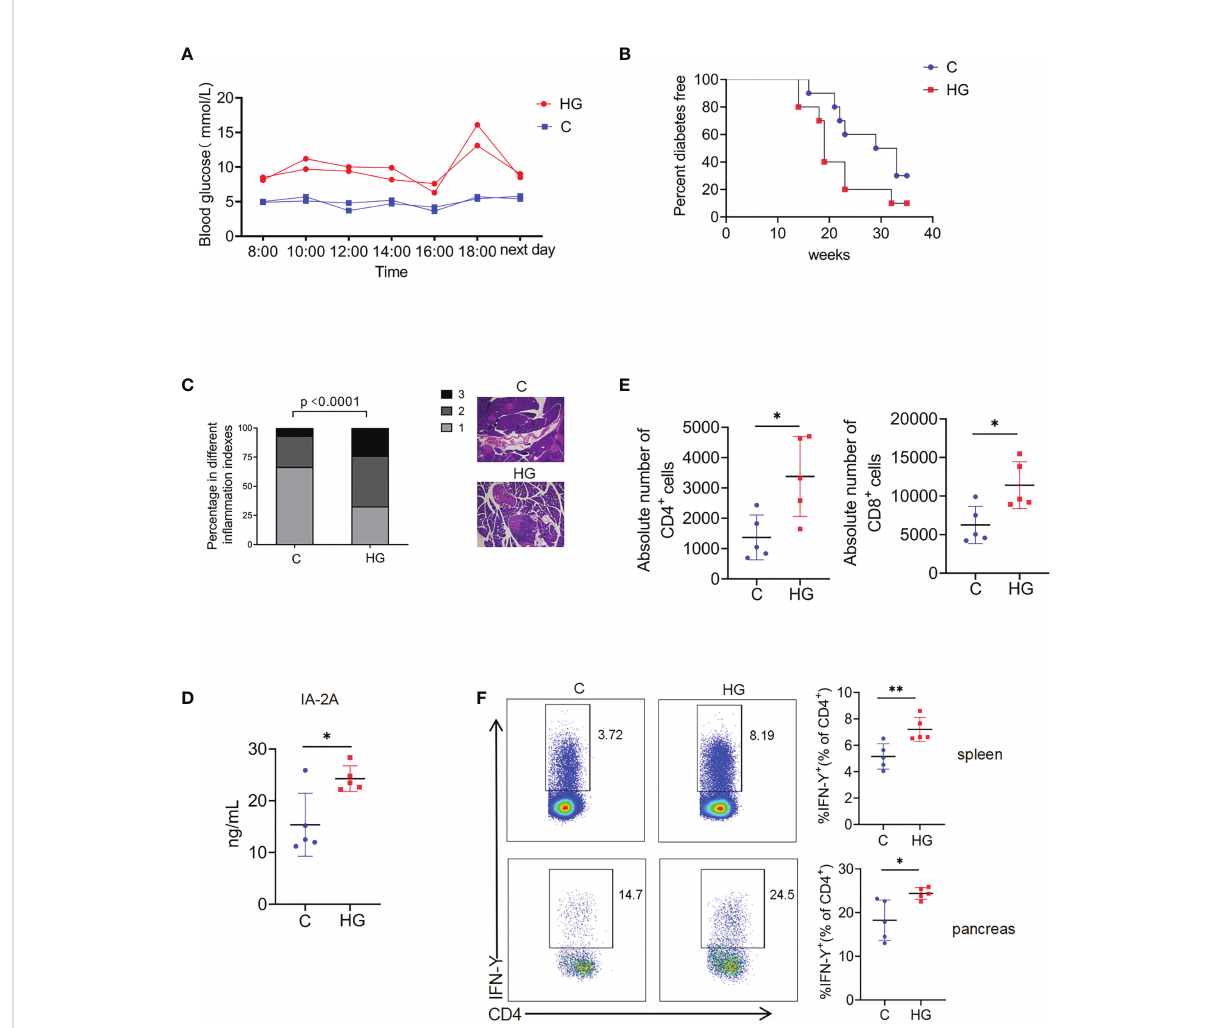
FIGURE 1 Sustained high-glucose intake aggravates islet in fl ammation and accelerates the onset of T1D in NOD mice (A) Blood glucose at different time points in a day in NOD mice given normal water (C) or high-glucose water (HG) (n=2). (B) The diabetes-free percentage in NOD mice given normal water (C) or high-glucose water (HG) over time, signi fi cance was determined by Gehan-Breslow-Wilcoxon test, P<0.05 (n=10). (C) Representative images of HE staining of pancreas (magni fi cation 20×) and insulitis scores in NOD mice given normal water (C) or high-glucose water (HG) (n=5). Statistical signi fi cance was analyzed by Chi square test, p<0.0001. (D) Serum concentrations of Insulinoma Associated-2 Autoantibodies (IA-2A) in NOD mice given normal water (C) or high-glucose water (HG) (n=5). (E) The absolute number of pancreas-in fi ltrating CD4 + and CD8 + T cells of NOD mice given normal water (C) or high-glucose water (HG) (n=5). (F) The secretion of IFN- g by CD4 + T cells in the spleen (up) and pancreas (down) of NOD mice given normal water (C) or high-glucose water (HG) (n=5). Data are representative of two independent experiments. Summary data are presented as mean ± SD. *p < 0.05, and **p < 0.01, unpaired two-tailed Student ’ s t